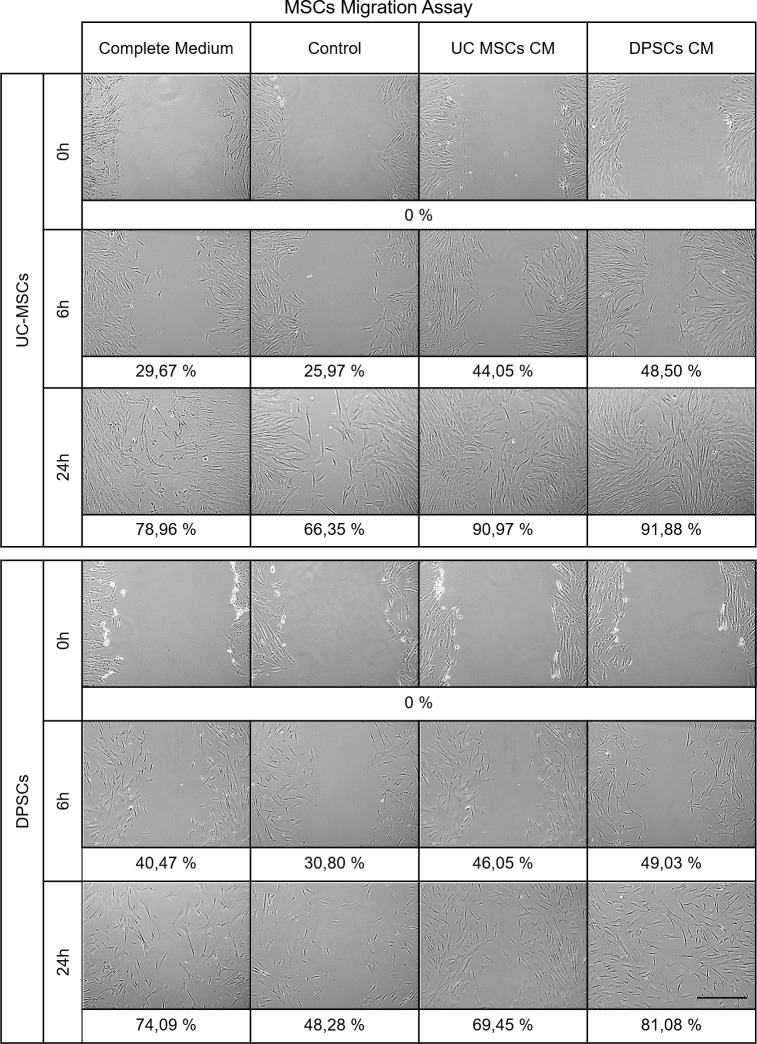
Migration assay of hMSCs.At 0, 6 and 24 hours of expansion in control or CMs supplemented media. Values are presented as percentage (%) of wound area coverage from the 0 hours baseline (scale bar = 200 μm).